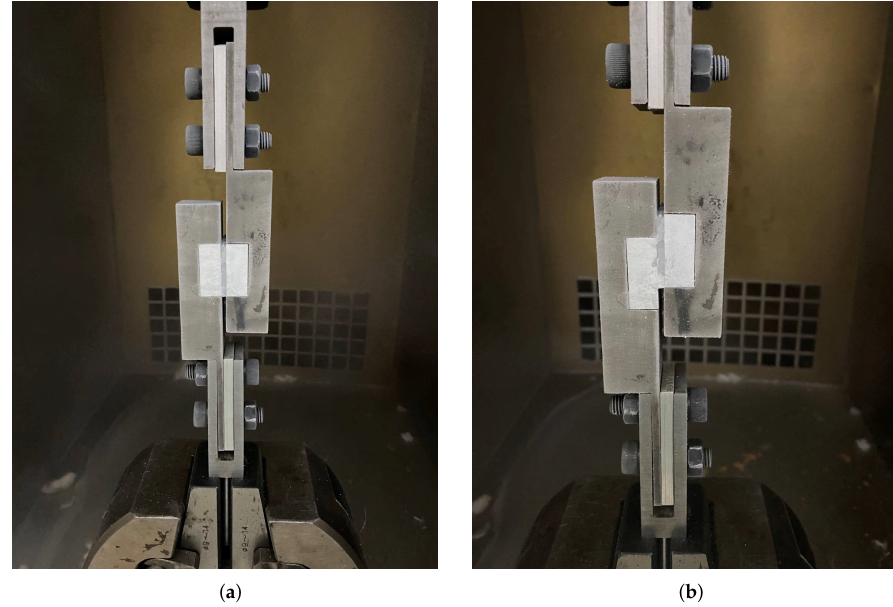
Figure 2. Assembly and loading drawing of test parts and fixture. ( a ) Drawing of test parts and fixtures. ( b ) Effect diagram of the tensile load destroying the adhesive ice